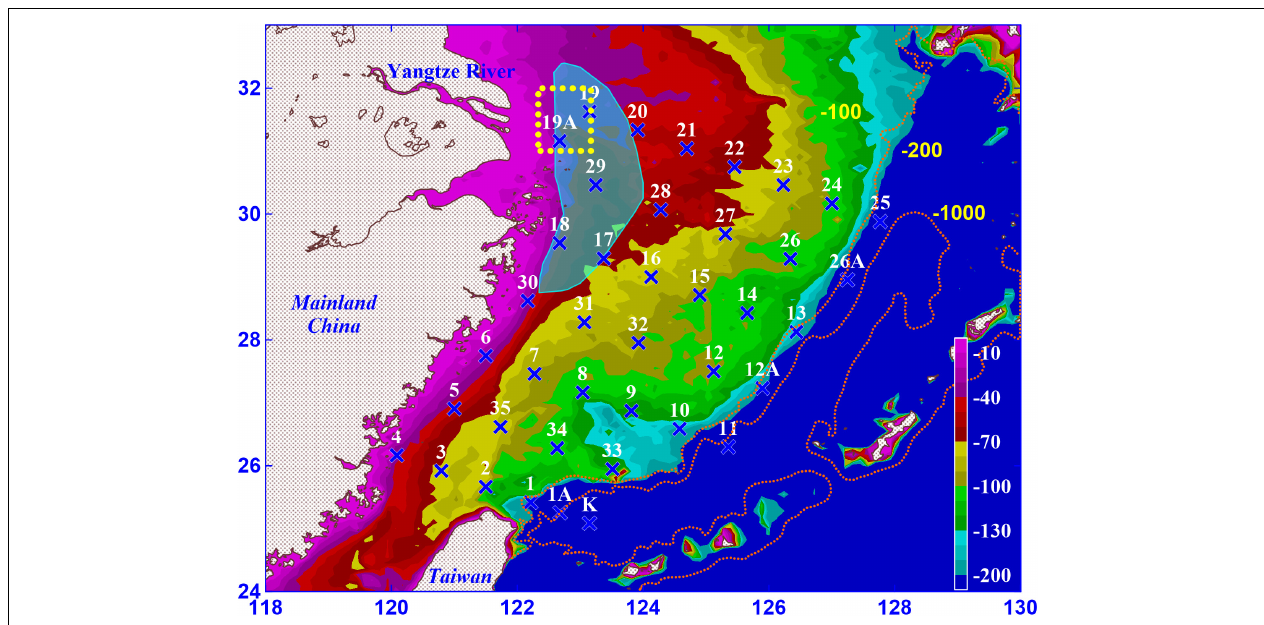
FIGURE 1 | Designed sampling stations in East China Sea are marked by an “x” with station number above the mark. The frequently observed hypoxic region off the Changjiang River estuary is shaded with light blue, modified after Li et al. (2002). The rectangle with a yellow a broken yellow line indicates the observed upwelling region proposed by Zhao et al. (2001). Bottom depth is indicated by color coding, and depth contours of 100, 200, and 1,000 m are also played as dashed